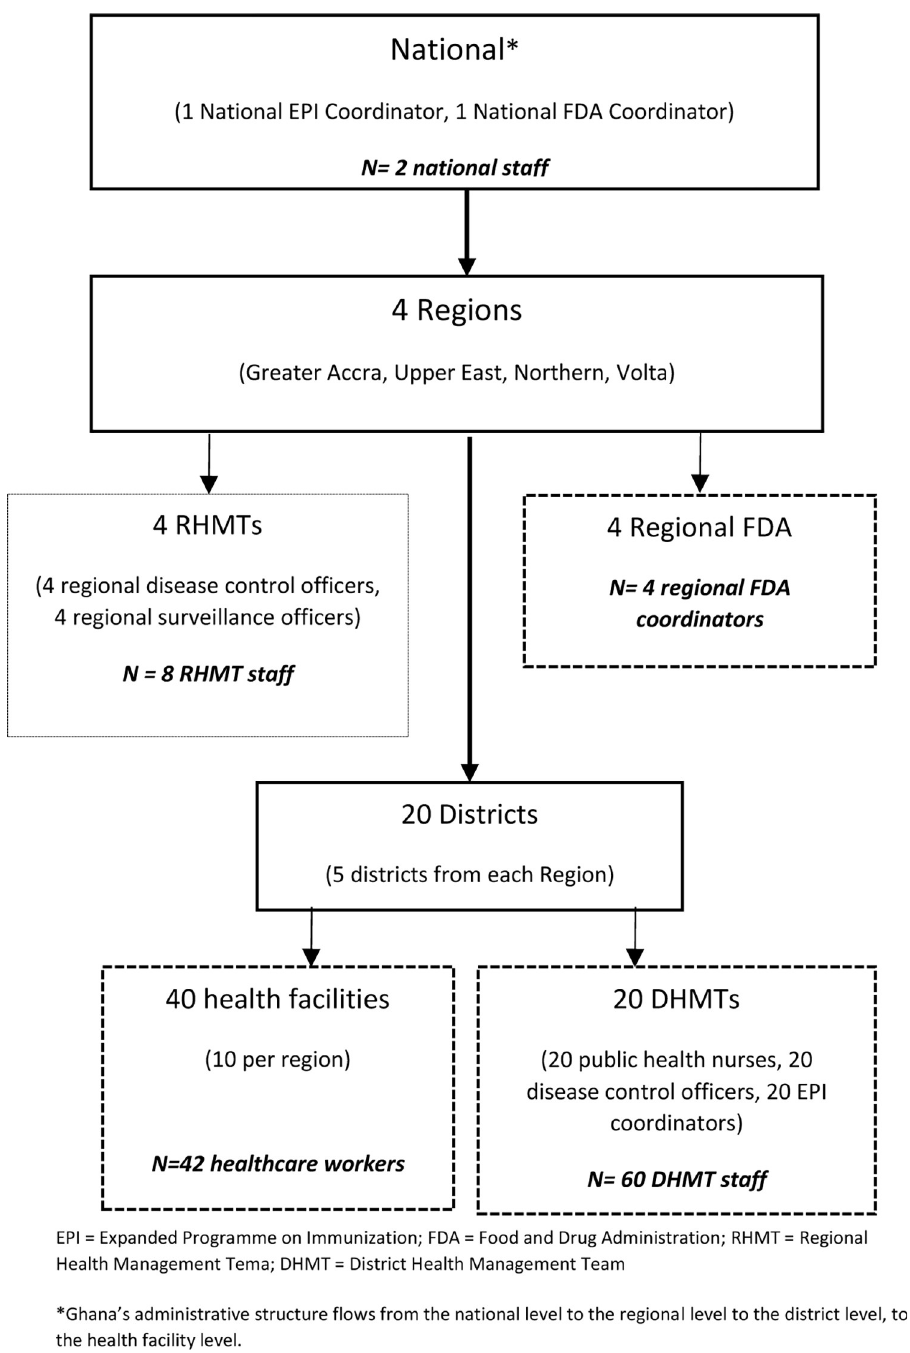
Fig 2. Approach to selecting respondents for key informant